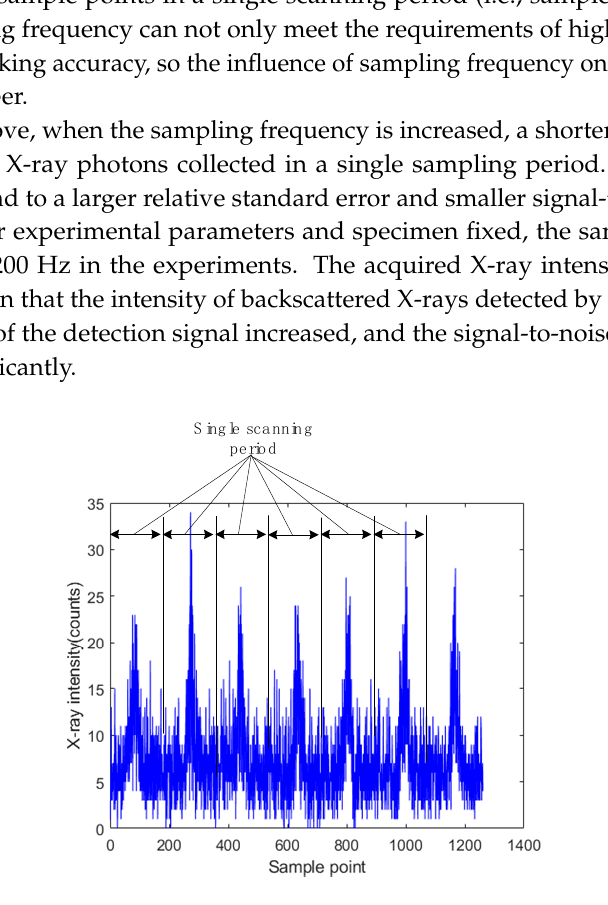
Figure 17. The X-ray intensity signal at 200 Hz sampling frequency.